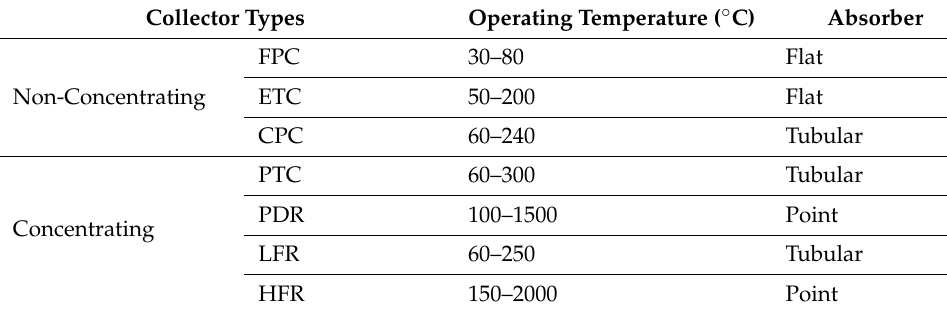
Figure 11. Heliostat field reflector (HFR) [80]. Table 1. Solar collector parameters [4,81].